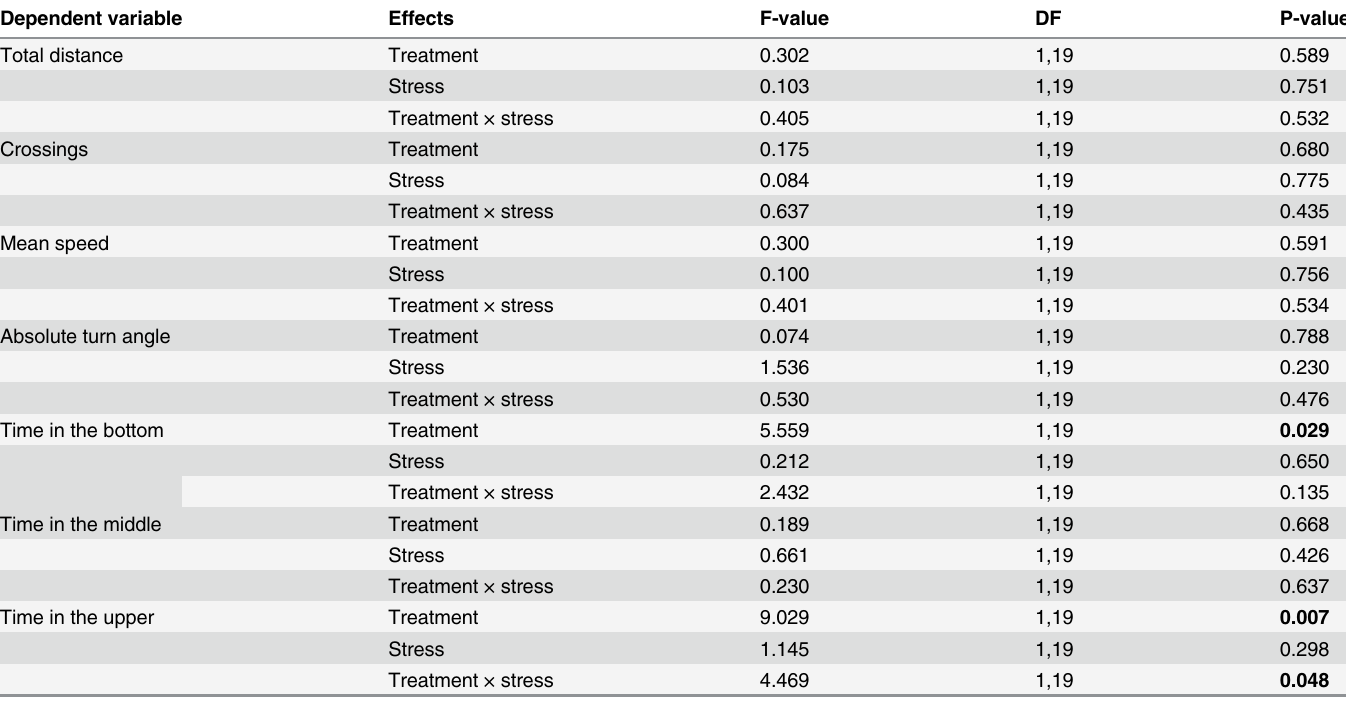
Table 2. Results of analysis of variance (ANOVA) for the behavioral tests.